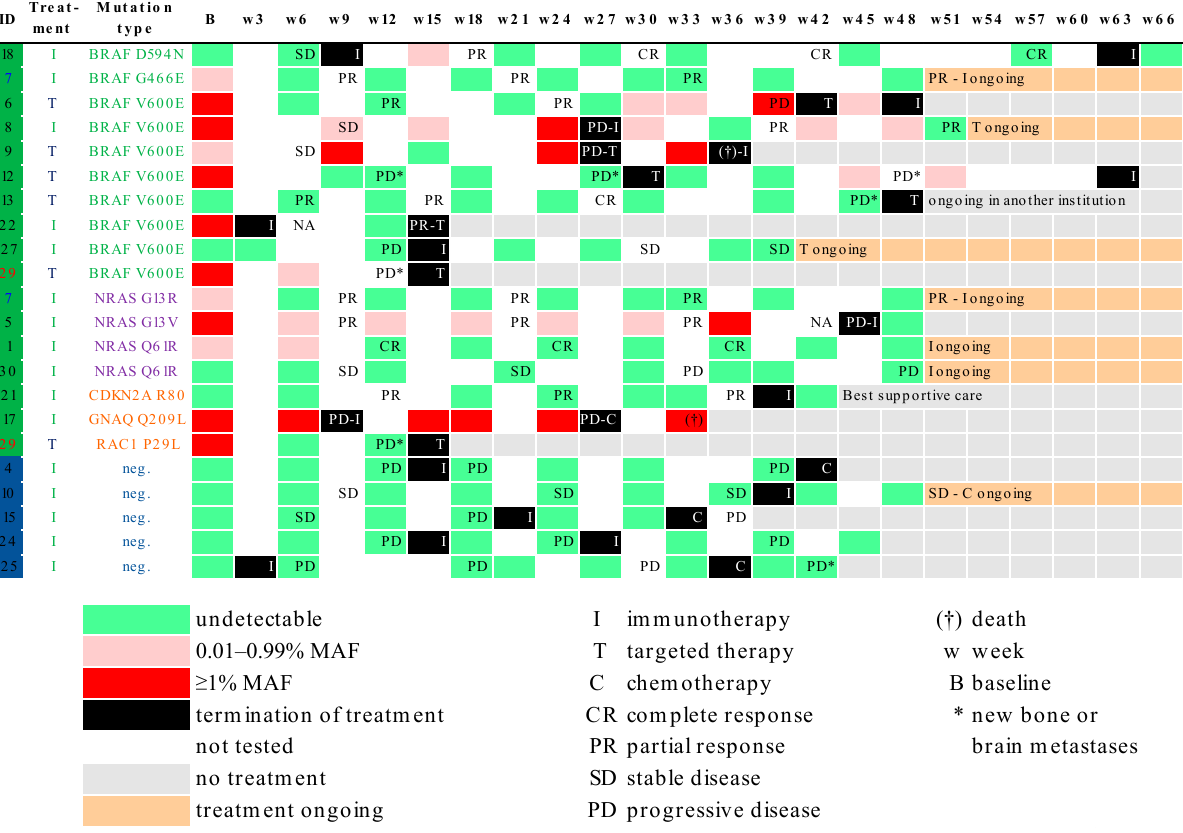
Figure 3. Heatmap showing mutation status and longitudinal ctDNA followup of individual patients at different time points during treatment (immunotherapy or targeted therapy) grouped by mutational status in the tissue/plasma (at least one melanoma-associated mutation detectable in tissue/plasma or tissue/plasma negative). Each row is an individual patient, and each column is a time point during followup (every three weeks). Termination of each treatment type is marked in black boxes. Grey boxes signify that patient did not receive treatment with either immunotherapy, targeted therapy, or chemotherapy anymore. MAF levels are marked by green boxes (undetectable), pink boxes (0.01–0.99% MAF), and red boxes ( ≥ 1% MAF). Time points at which there was no evaluation of ctDNA are shown in white color. Two patients had two different mutations in tissue as well as in the plasma samples and are listed twice in heatmap (ID 7 in blue and ID 29 in red). MAF: mutant allele frequency.